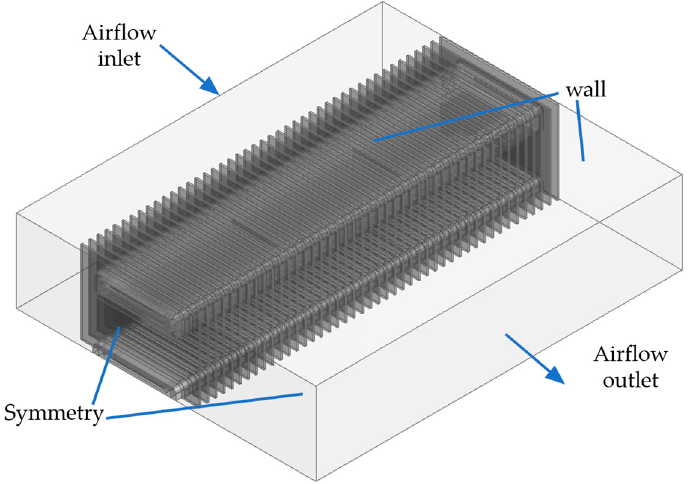
Figure 9. Computational domain.